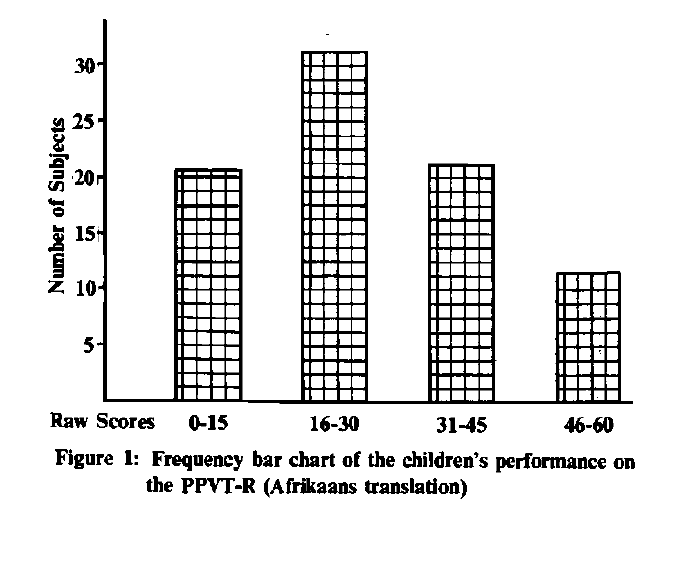
Figure 1: Frequency bar chart of the children's performance on the PPVT-R (Afrikaans translation)